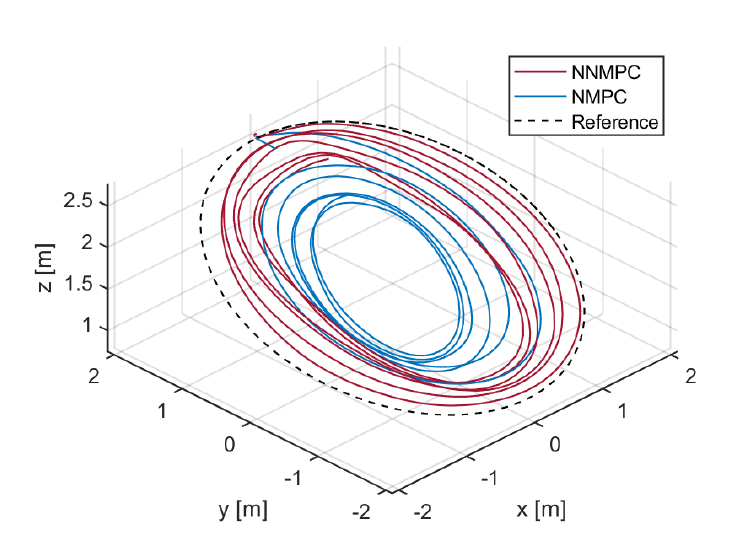
Figure 8. 3D view of the sinusoidal trajectory tracking result for NMPC and NNMPC in simulation.